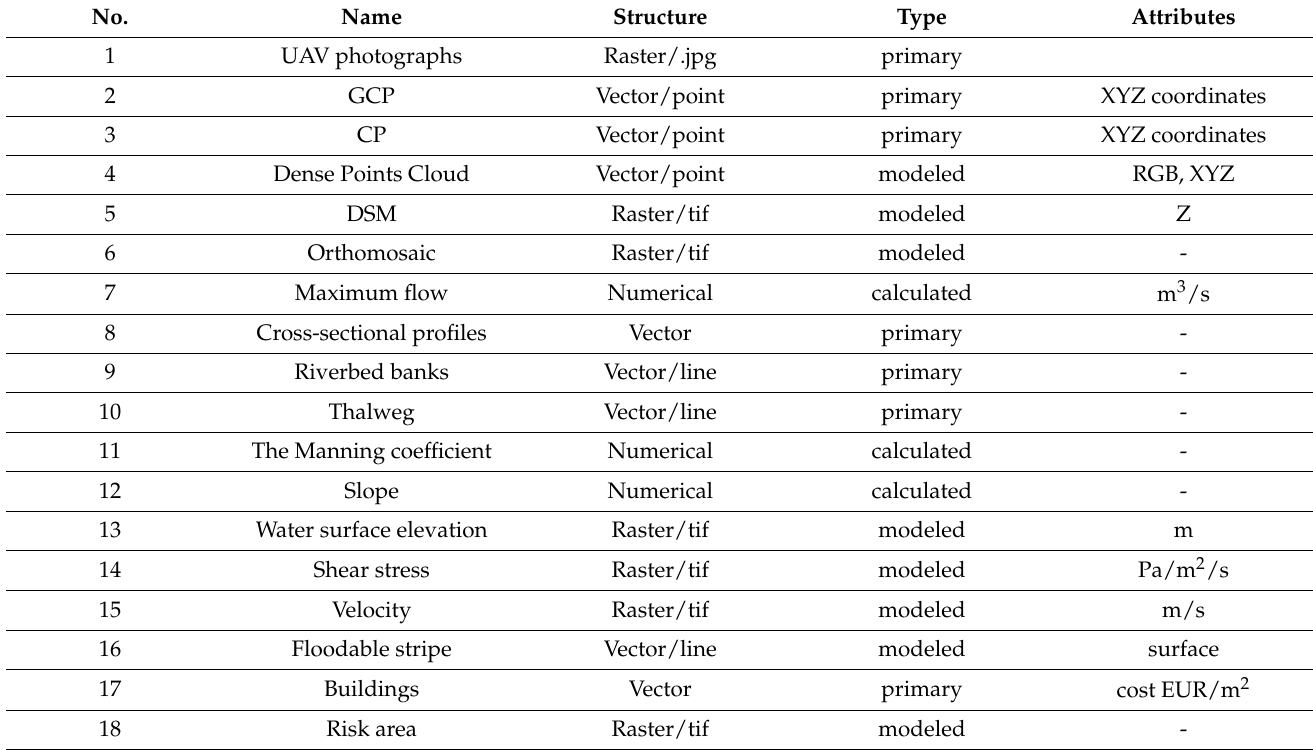
Table 1. Database used in spatial